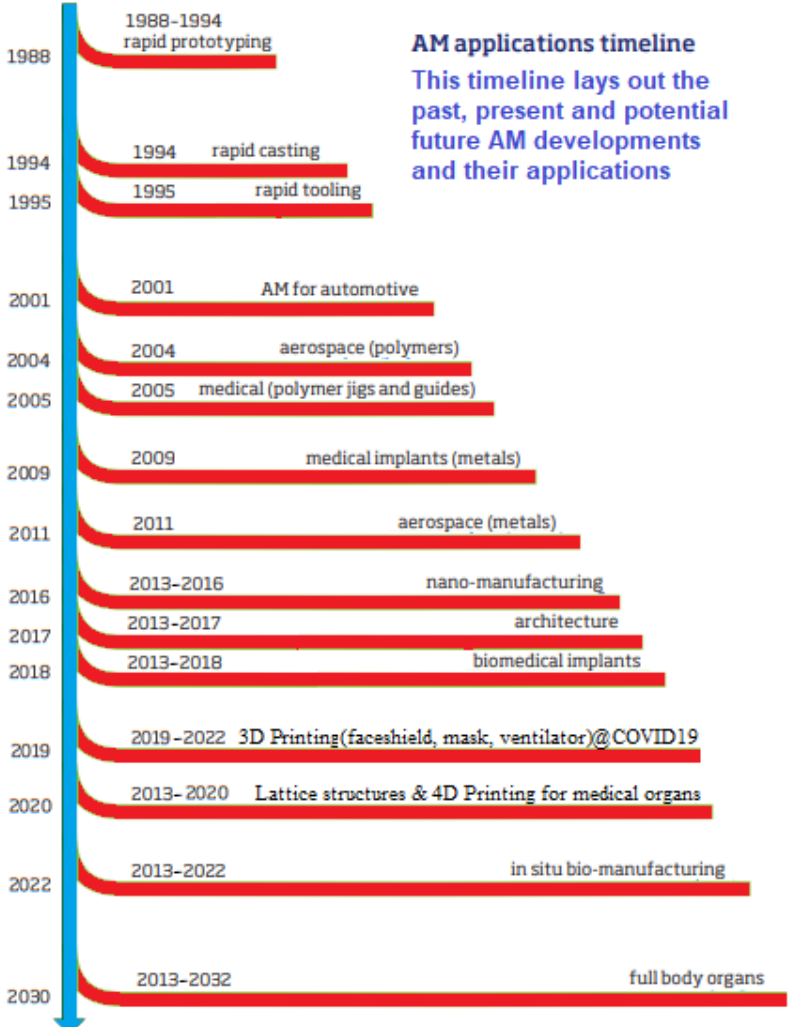
Figure 1. The timeline for the developments on additive manufacturing (AM), showing the past, present, and potential future (Adapted from original image with permission. Courtesy: Graham Tromans of Graham Tromans Associates, London, UK & Terry Wohlers of Wohlers Associates, Youngstown, OH, USA).